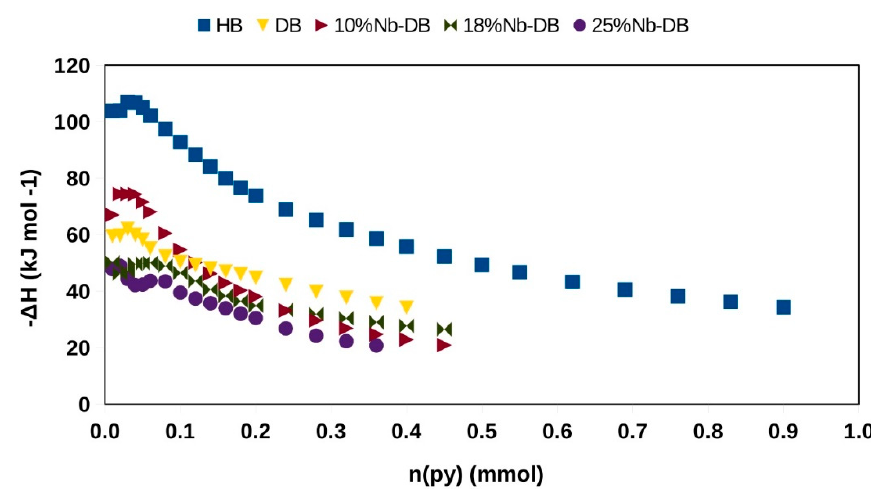
Figure 6. Calculated enthalpy di ff erence ( ∆ H) versus the number of mmoles of Py added. Table 5. The number of acid sites (n i , mmol g − 1 ) and enthalpies ( − ∆ H i , kJ mol − 1 ) of the sites obtained by microcalorimetry of Py adsorption, using a two-site model.